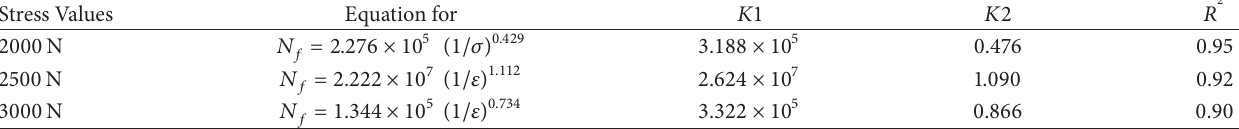
Table 5: Regression equations for fatigue life due to the variation of stress along with regression parameters.